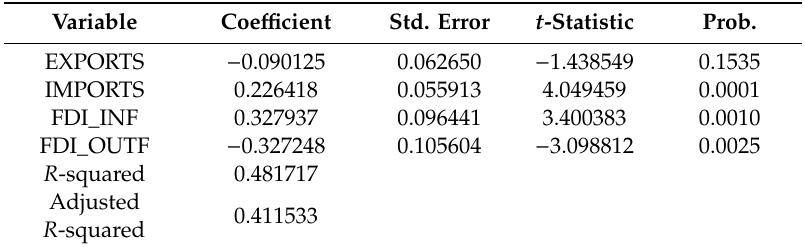
Table 5. Panel fully modified least squares (FMOLS).